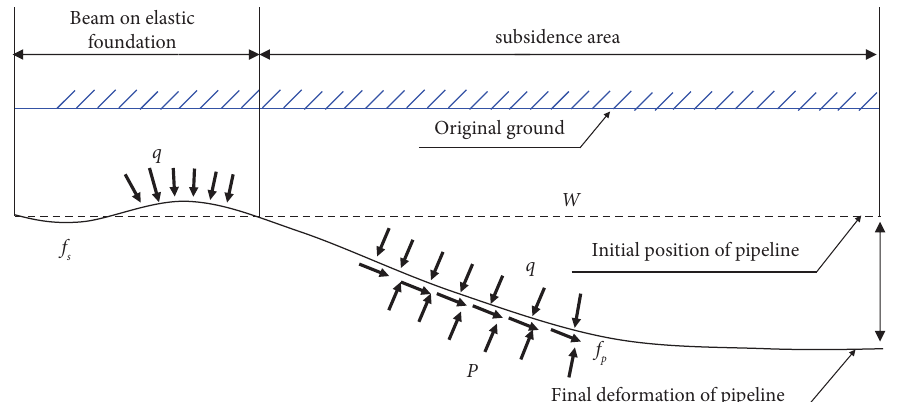
Figure 8: Te deformation analysis model of buried pipelines under the action of surface subsidence